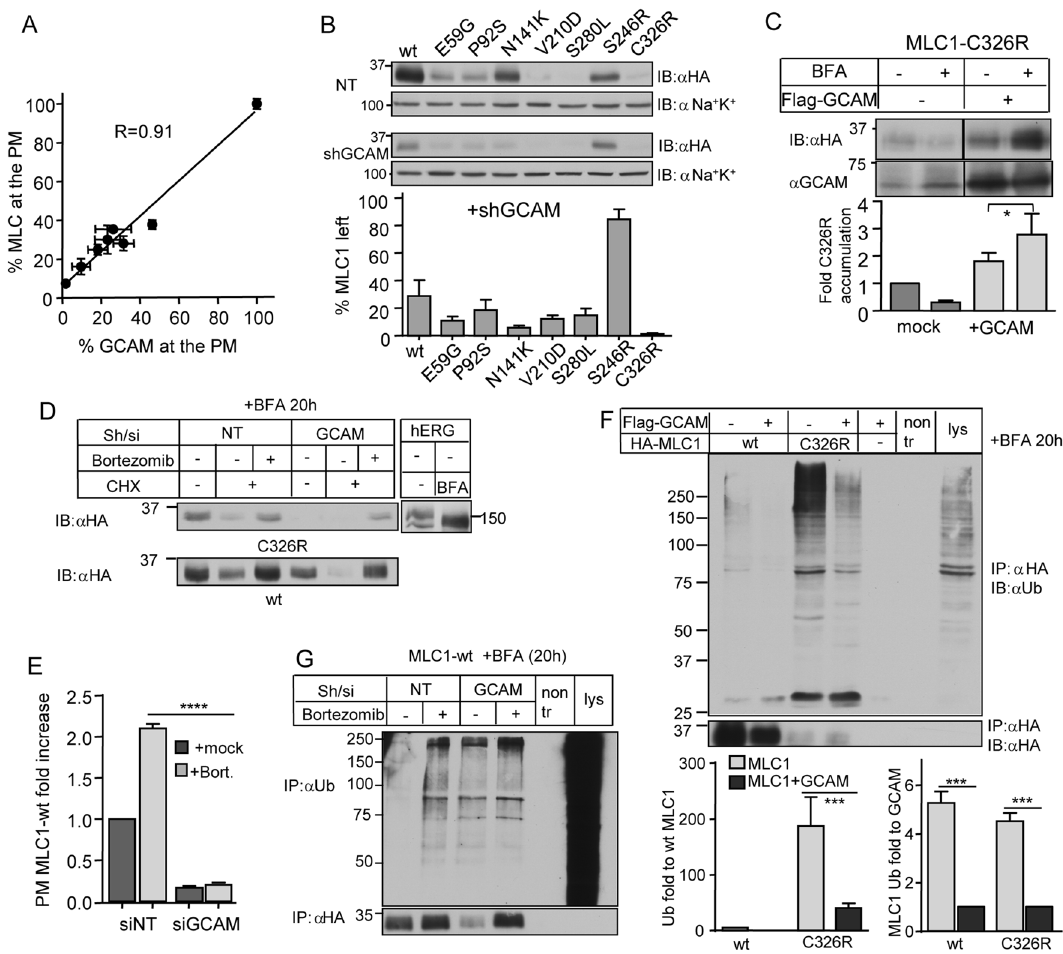
Figure 6. The cell adhesion protein, GlialCAM, protects MLC1 against ubiquitination and degradation at the ER. ( A ) The correlation of the PM expression between endogenous GlialCAM (GCAM) and exogenous MLC1-wt was measured using cs-ELISA in HeLa cells and expressed as a percentage of mock-treated MLC1-wt cells. The GCAM downregulation efficiency was altered by using different amounts of siGCAM. ( B ) Western blot analysis of GCAM downregulation on the cellular expression of MLC1 variants was determined after depleting ~ 60% of GCAM with short hairpin (sh)RNA or shNT (non-targeted). Total MLC1 expression was quantified against the loading control Na + –K + -ATPase (Na + K + ). ( C ) GlialCAM overexpression protects MLC1-C326R against rapid ER elimination. Immunoblot analysis of MLC1 and GCAM expression levels was carried out after 20 h BFA (5 µg/ml) or mock-treated HeLa cells with or without GlialCAM overexpression.